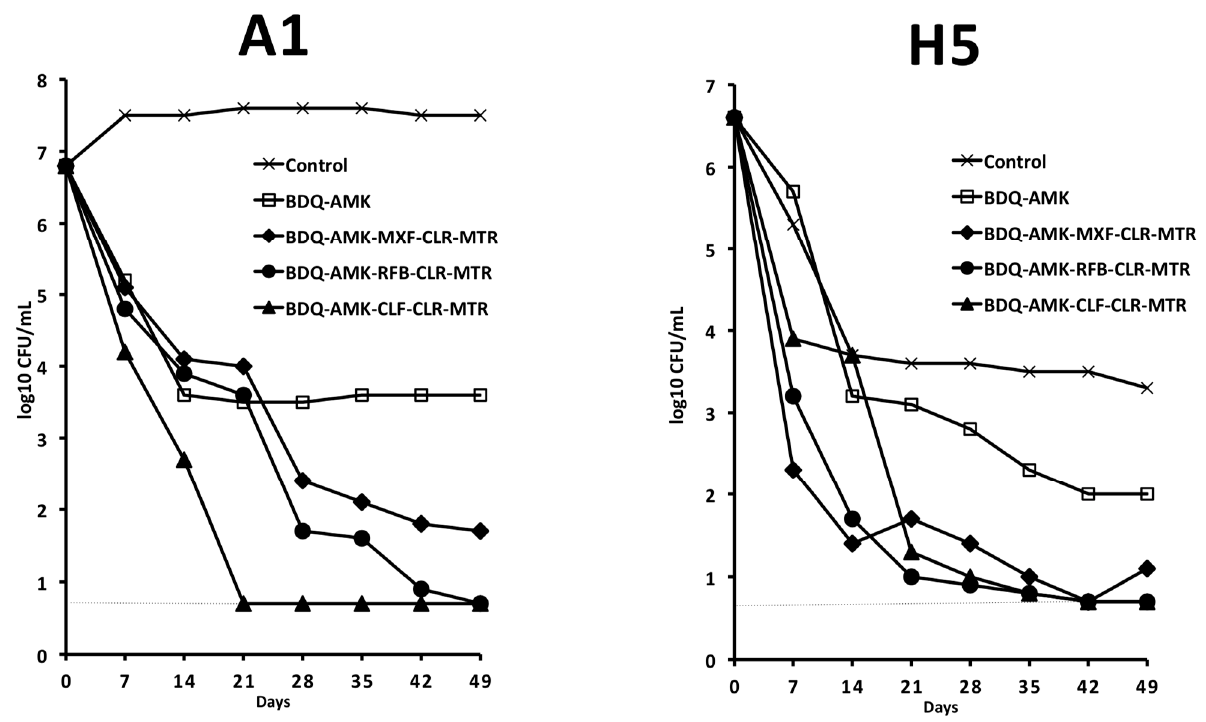
Figure 7. Activity against A1 and H5 cells of 5-drug combinations containing BDQ-AMK added with RFB (or CLF or MXF, both potentiating A1 cells), and with CLR-MTR (potentiating H5 cells). Dashed lines indicate the limit of detection (5 CFU/mL). A representative experiment out of two is